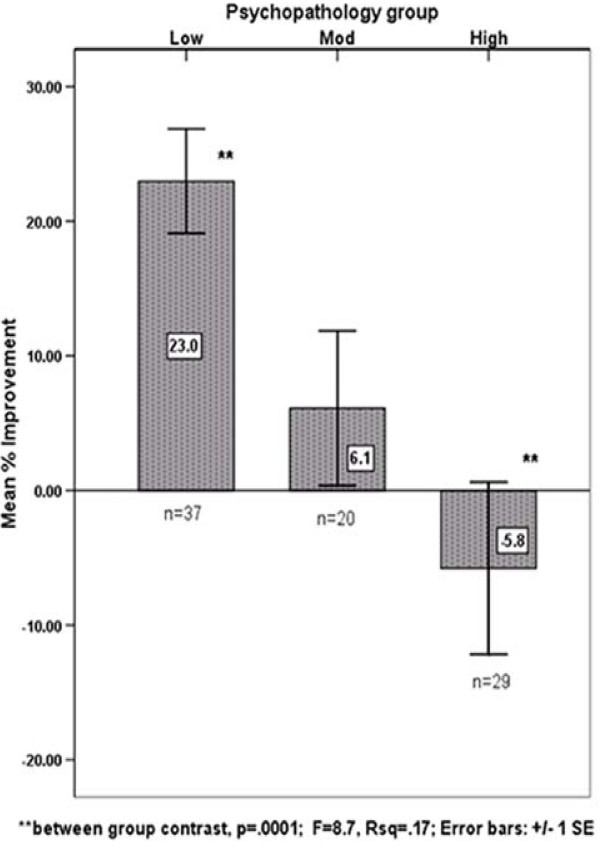
Psychopathology Group and Pain Improvement. **between group contrast, p = .0001; F = 8.7, Rsq = .17; Error bars: +/- 1 SE